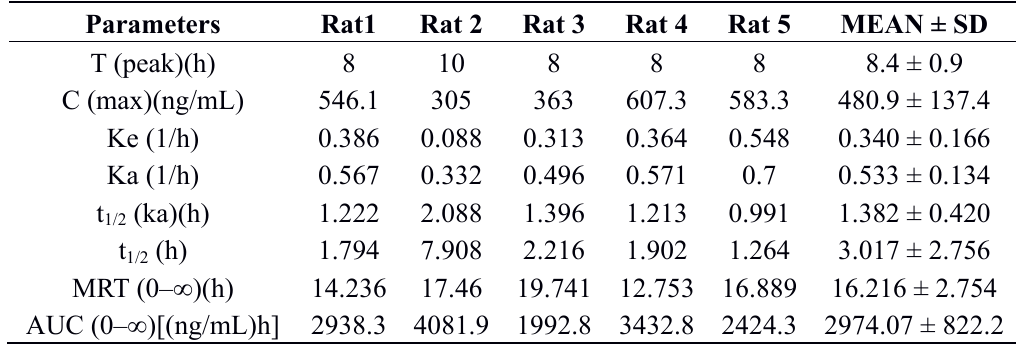
Table 18. Pharmacokinetic parameters of TA-III after intragastrical administration to rats at a dose of 75 mg/kg.